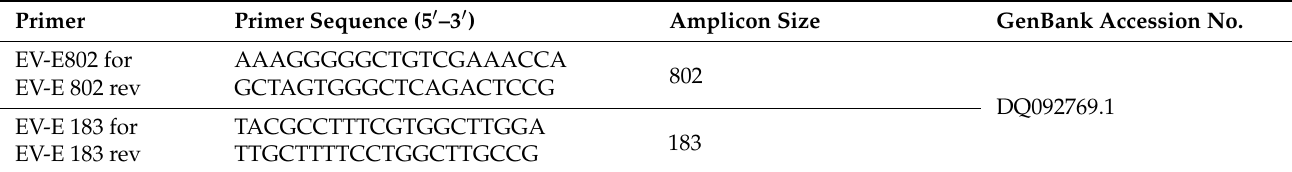
Table 1. Primer sequences used for the detection of intracellular enterovirus E